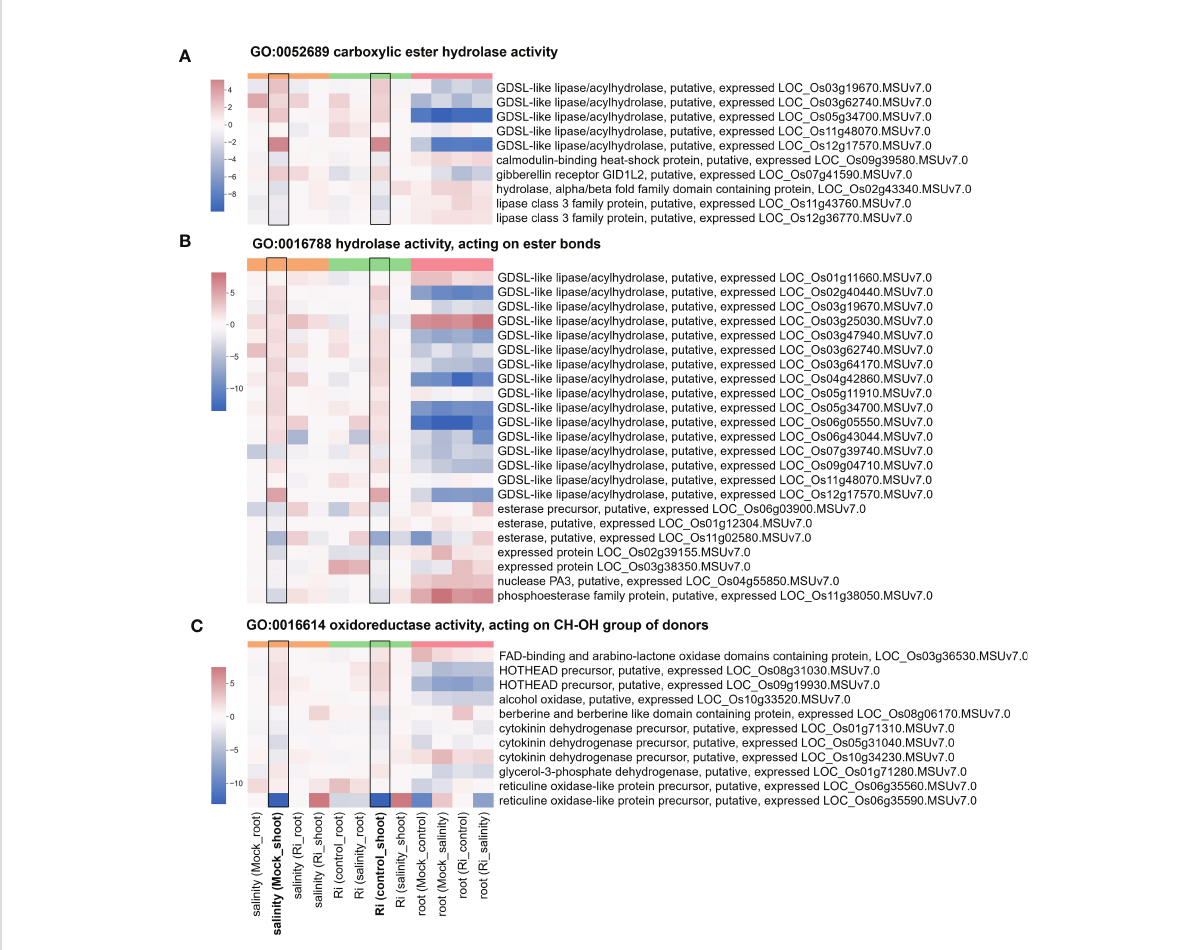
FIGURE 6 Heatmap showing the fold change of DEGs belonging to ester-related and oxidoreductase activity GO terms (A) Expression pro fi le of DEGs from region 7 with the GO term “ GO:0052689 carboxylic ester hydrolase activity ” . (B) Expression pro fi le of DEGs from region 7 with the GO term “ GO:0016788 hydrolase activity, acting on ester bonds ” . (C) Expression pro fi le of DEGs from region 7 with the GO term “ GO:0016614 oxidoreductase activity, acting on CH-OH group of donors ” . The log2(fold change) values of DEGs from the selected GO terms were visualized with a heatmap. The color bar on top of the heatmap indicates the DE comparison groups: orange – salinity effect; green – AM symbiosis; pink – tissue difference. On the x-axis, each column represents a pairwise comparison to show the effect causing the DE, and inside the parentheses are the